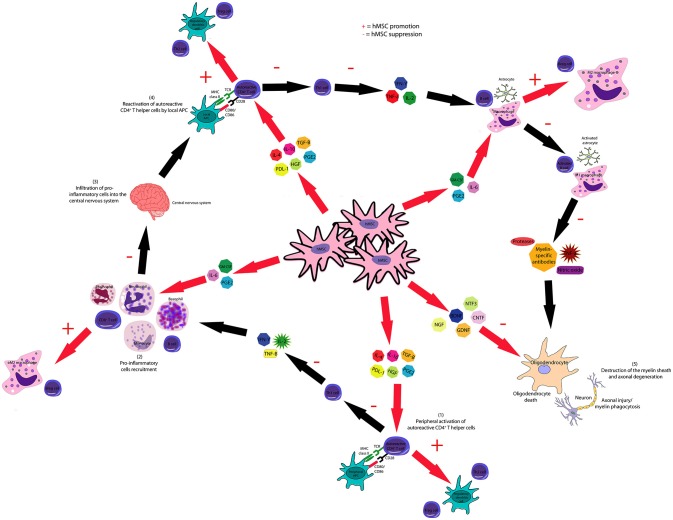
hMSCs inhibits the pathological course of multiple sclerosis through several mechanisms. hMSC-produced IL-4, IL-10, HGF, PGE2, PDL-1, and TGF-β inhibit the activation of autoreactive CD4+T cells and their differentiation to Th1 cells and stimulate the generation of Breg, Treg, and Th2 lymphocytes. hMSCs inhibit the activation of dendritic cells and stimulate the generation of regulatory dendritic cells. hMSC-produced IL-6, PGE2, and GM-CSF suppress astrocyte activation and macrophage polarization to M1, though favors M2 polarization. hMSCs-produced neurotrophic factors BDNF, CNTF, GDNF, NGF, and NTF3 inhibit the destruction of the myelin sheath and axonal degeneration.